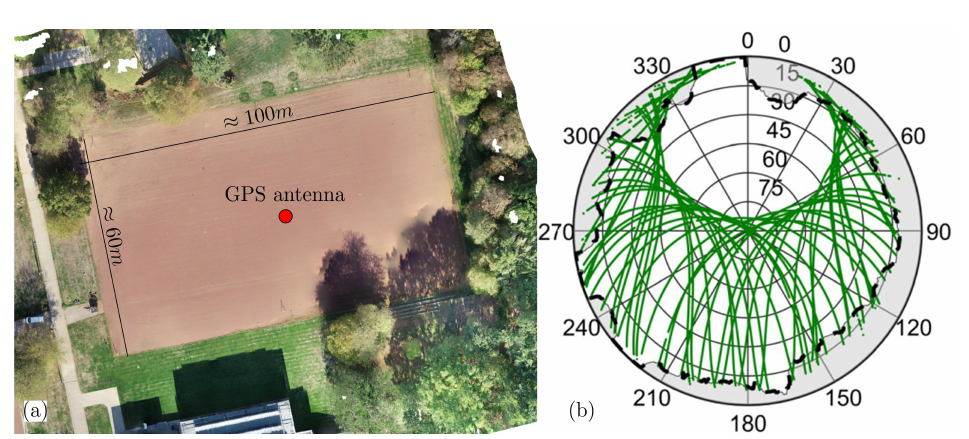
Figure 14. ( a ) Orthophoto of the test area from a UAV flight. The red point marks the location of the GPS antenna on the cinder pitch. ( b ) Obstruction adaptive elevation mask (black dashed line) of test area determined from a georeferenced terrestrial laser scanner (TLS) point cloud. The green lines show the GPS satellite tracks during the 24 h observation